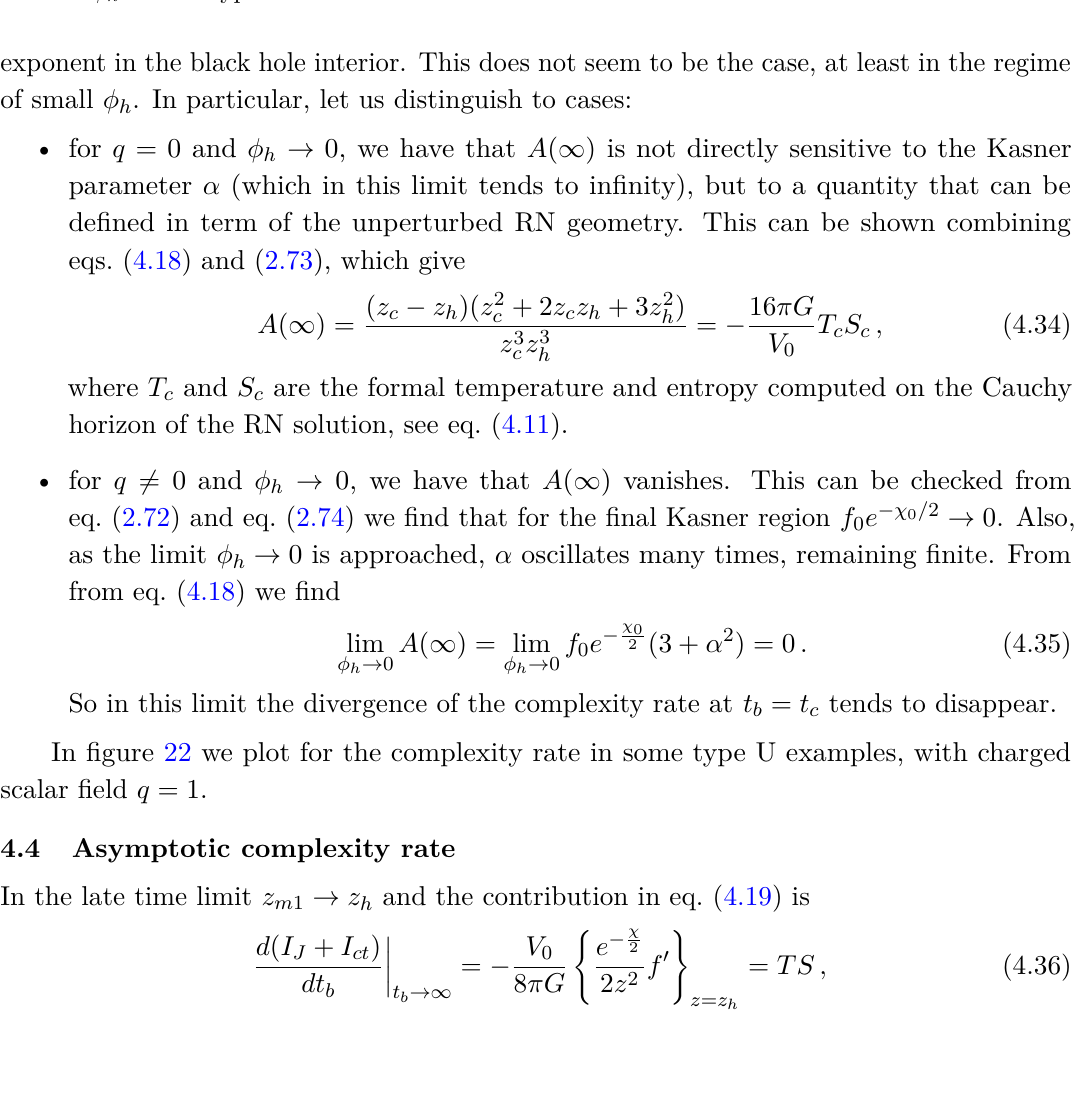
Figure 22 . Complexity rate for q = 1 and ρ = 2 as a function of t b for various values of φ h and L ct = 1 . The divergence in the complexity rate occurs at t b = t c and is shown here for a particular value of φ h = 0 . 4 . Type U